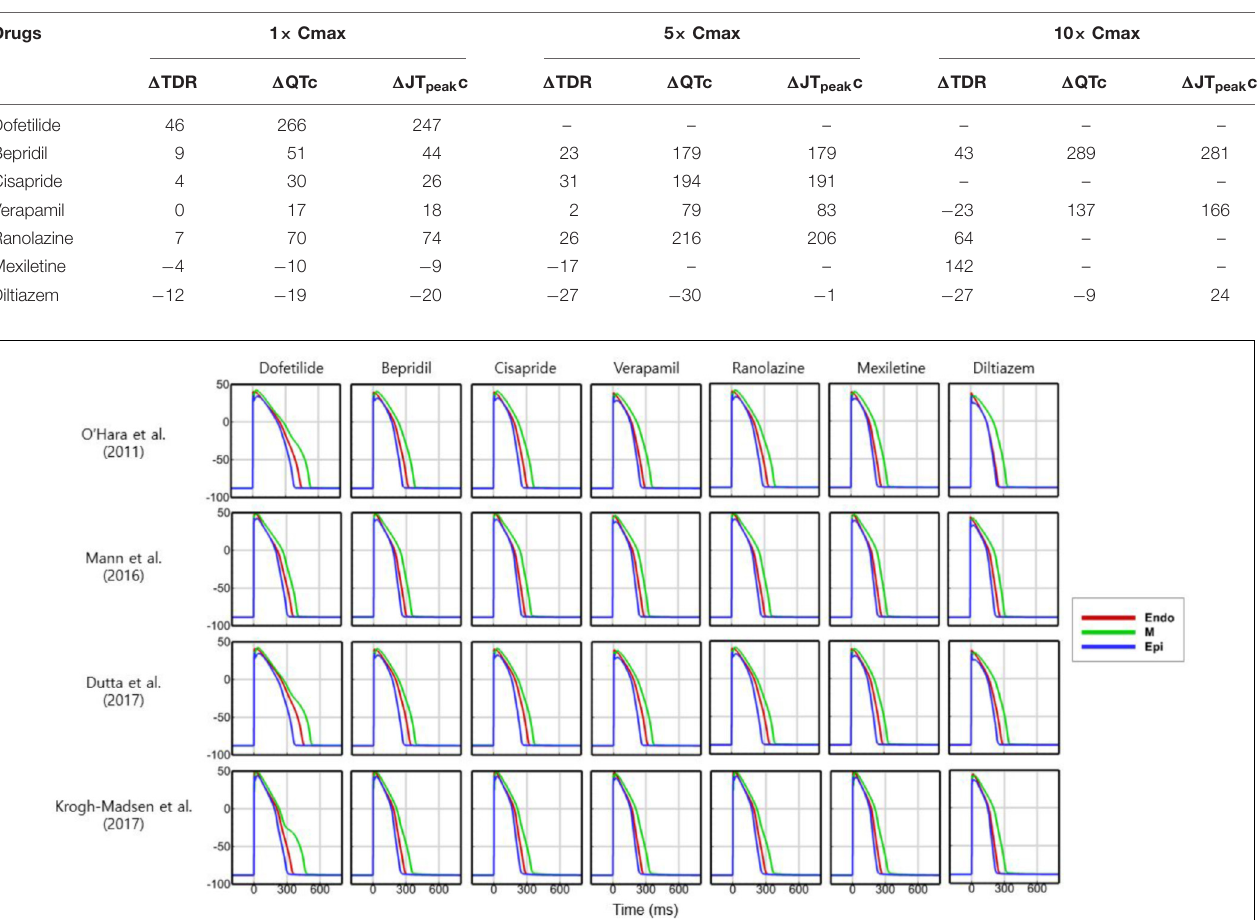
TABLE 4 | Simulated changes in TDR, QTc, and JT peak c according to drug concentration (Unit: ms). Drugs